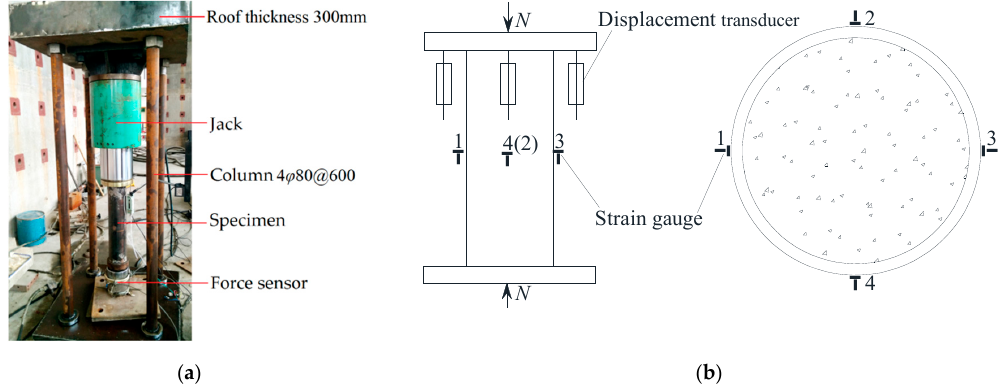
Figure 3. Loading and testing: ( a ) Test setup; ( b ) Schematic diagram of the layout of displacement transducer and strain gauge.